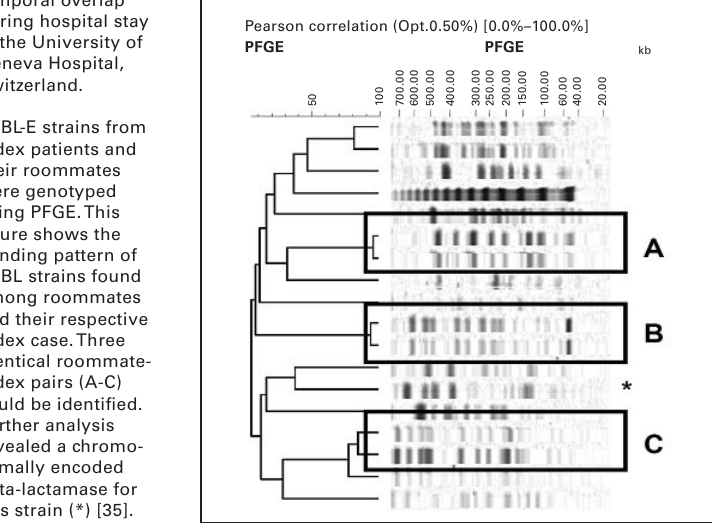
Pulsed-field gel electrophoresis (PFGE) of isolates from ESBL-E index cases and roommates that shared the same clone and had a temporal